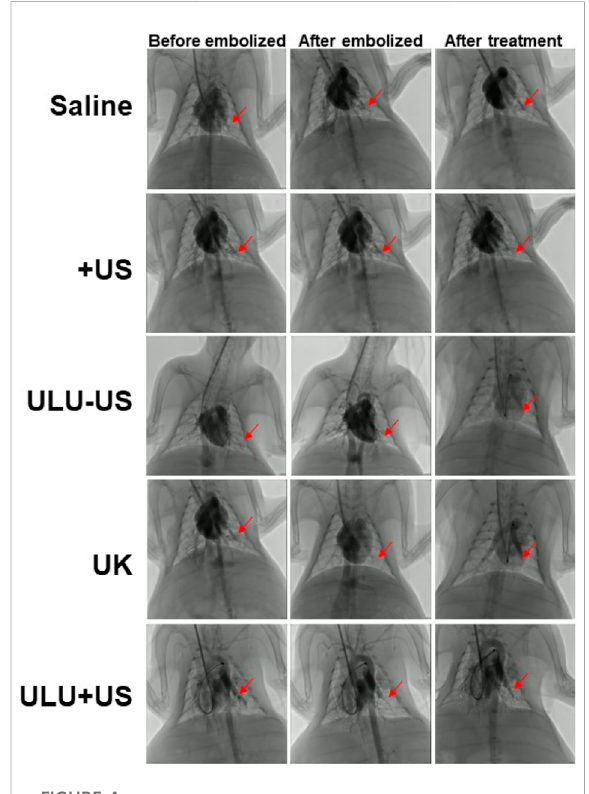
FIGURE 4 Digital subtraction imaging was used to evaluate the effect of pulmonary thrombolysis in rabbits receiving different treatment methods (Saline, US, ULU-US, United Kingdom, ULU + US, among the three groups (ULU-US, United Kingdom, ULU + US) had the same urokinase dose of 2,000 units, red arrows indicate recovery before and after pulmonary embolization and after treatment, n =